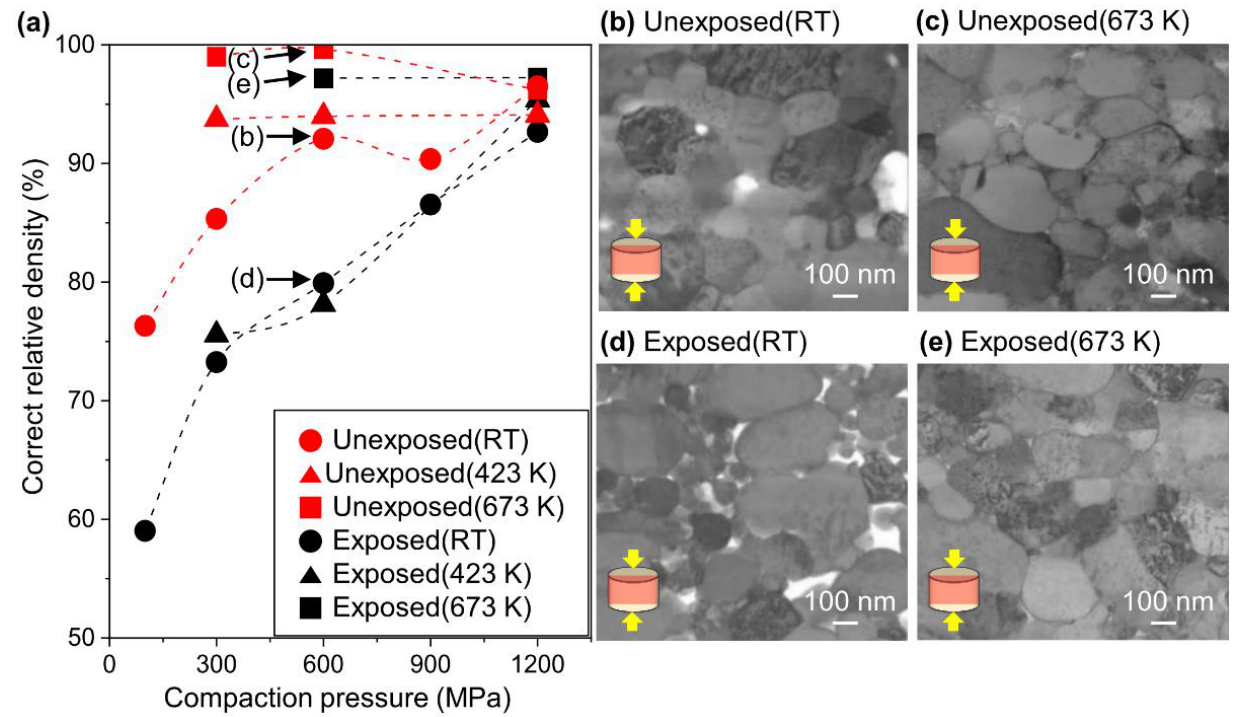
Figure 2. ( a ) Correct relative density of Al compacts as a function of compaction pressure. The dotted lines are a guide for the eye. ( b – e ) Annular bright-field (ABF)-STEM images of unexposed and exposed Al compacts pressed under 600 MPa along a direction of the arrows (insets) with and without sintering at 673 K. ( b ) Unexposed Al compact pressed at RT, ( c ) unexposed Al compact sintered at 673 K, ( d ) exposed Al compact pressed at RT, and ( e ) exposed Al compact sintered at 673 K.